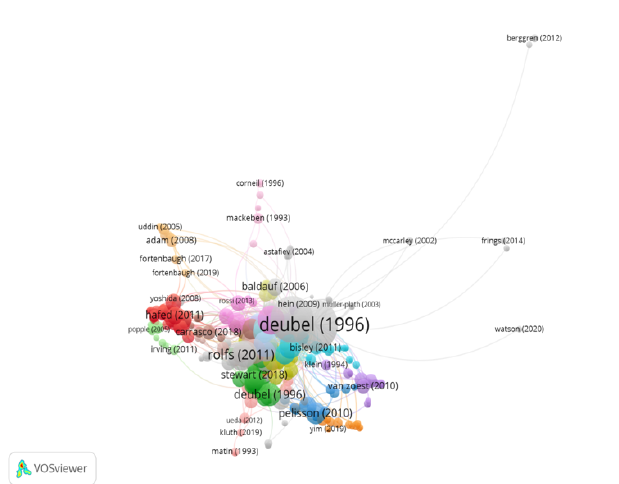
Figure 5. Citation network in Group 3